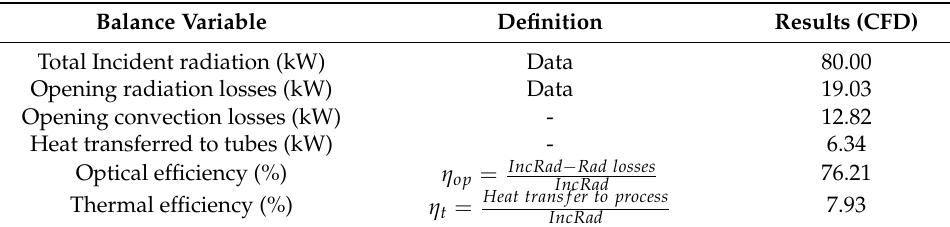
Table 3. Thermal balance in solar